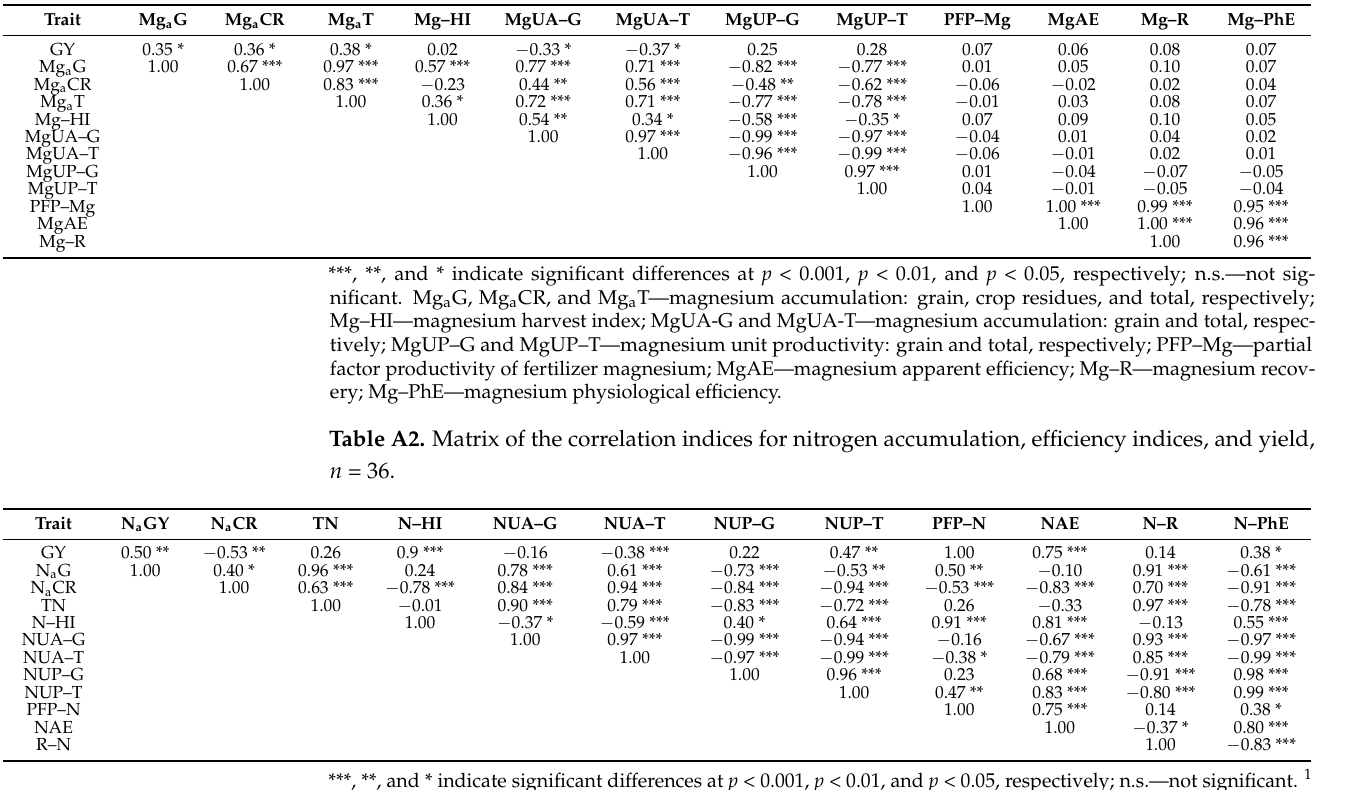
Table A1. Matrix of the correlation indices for magnesium accumulation, efficiency indices, and yield, n = 36.